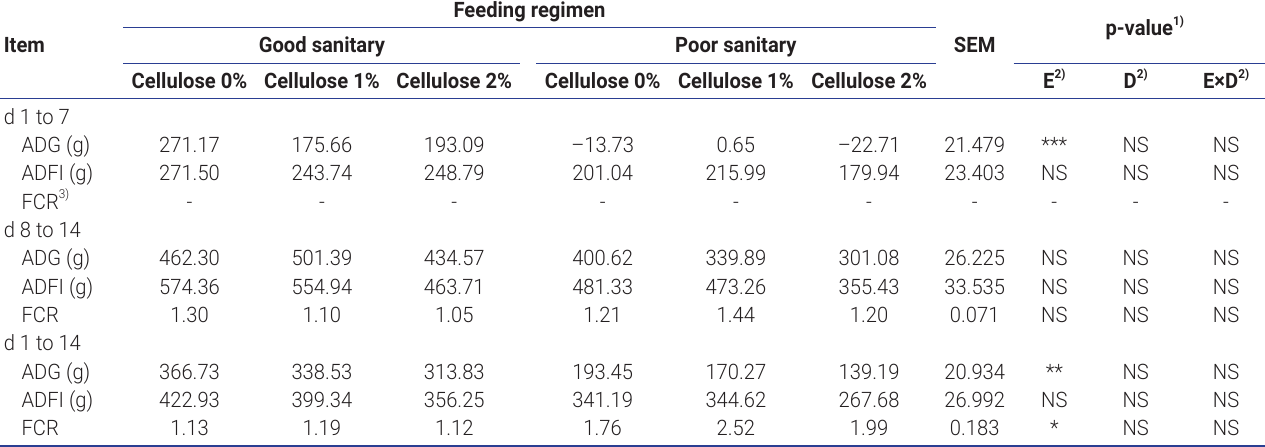
Feeding regimen